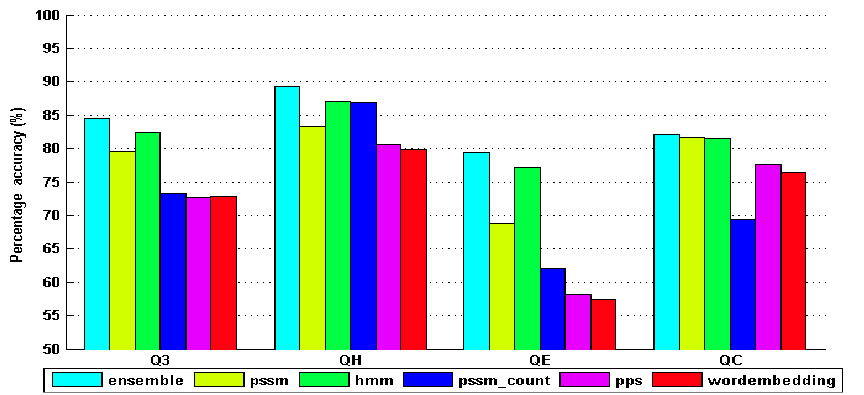
Figure 2. Q 3 accuracy of ensemble model and five sub-models for the validation set. Figure 2. Q (cid:2871) accuracy of ensemble model and five sub-models for the validation set. Table 1. segment overlap measure ( SOV) scores and (matthews correlation coefficients) MCC results by six different methods for the validation set.